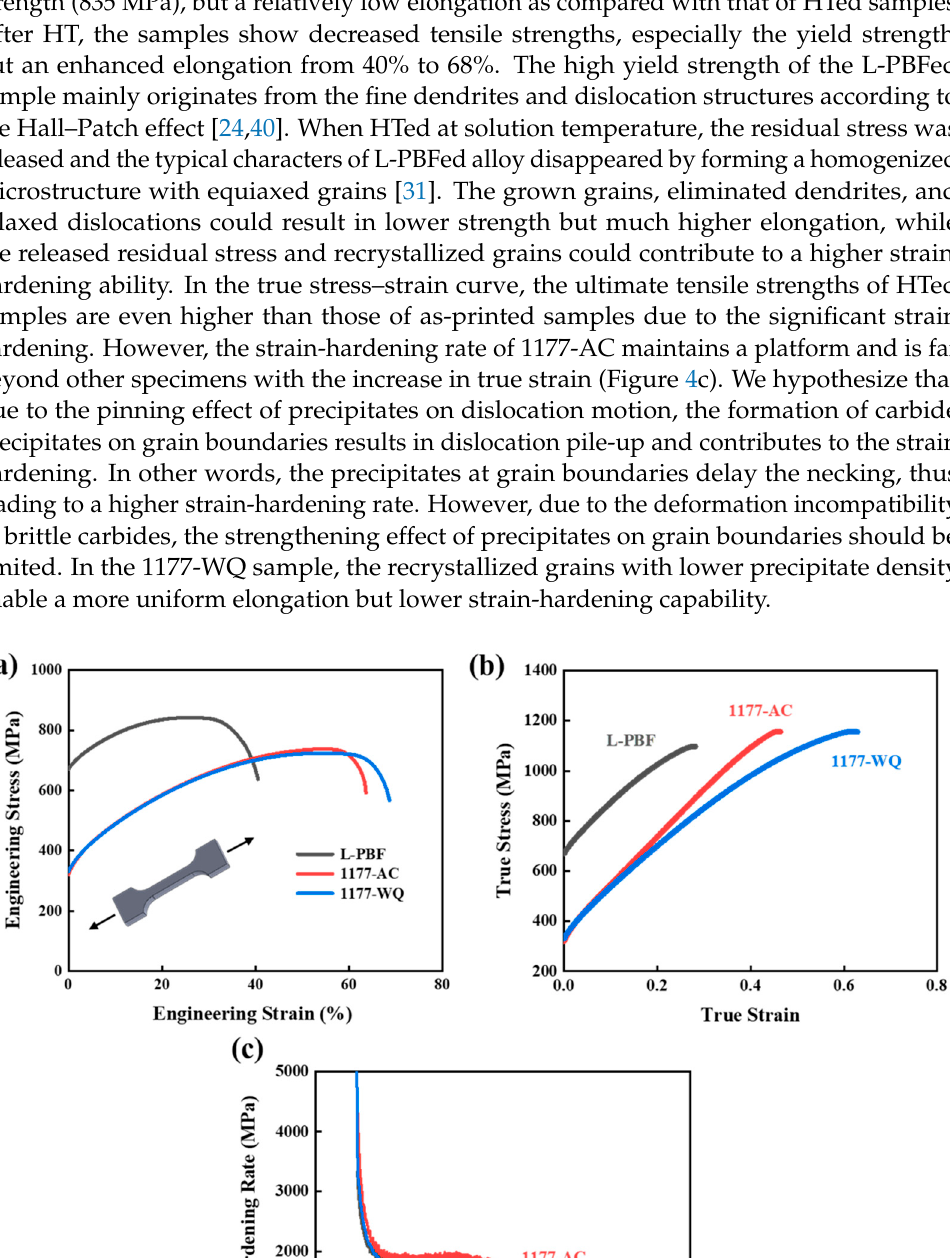
Table 2. Mechanical properties of GH3536 superalloy at room temperature.